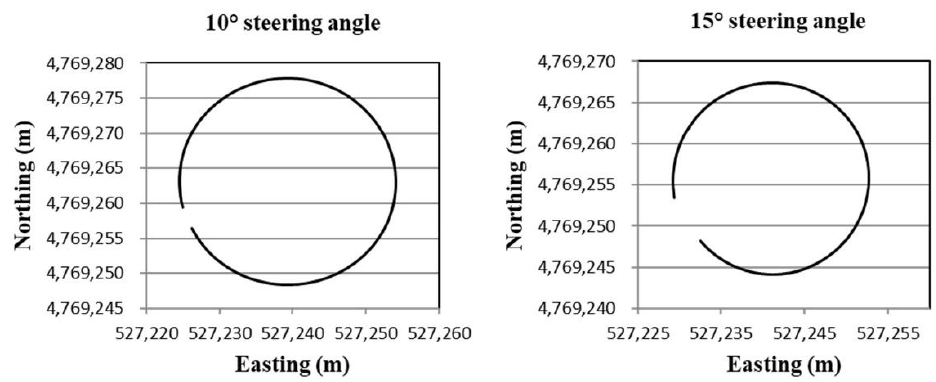
Figure 4. Circular trajectories of the tracked combine harvester at 10° and 15° input steering angles.